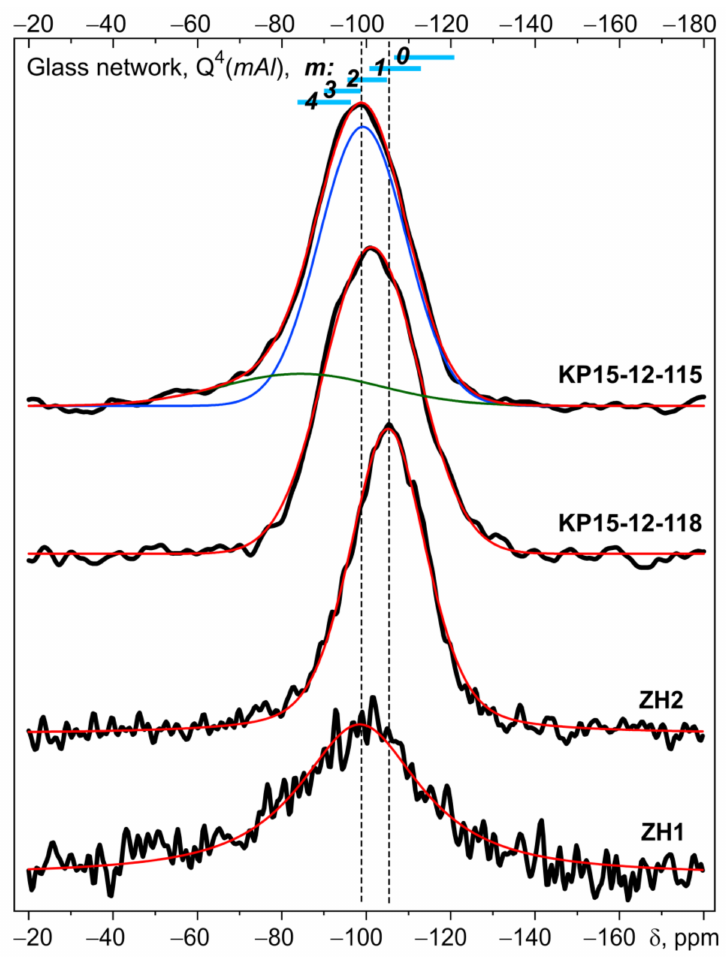
Figure 8. The shape of the isotropic 29 Si MAS NMR components of the studied glasses. Black line— experimental, and red lines—fitted spectra. The ranges of chemical shifts of Q 4 ( m Al) configurations of SiO 4 -units [26,49] are depicted by the blue